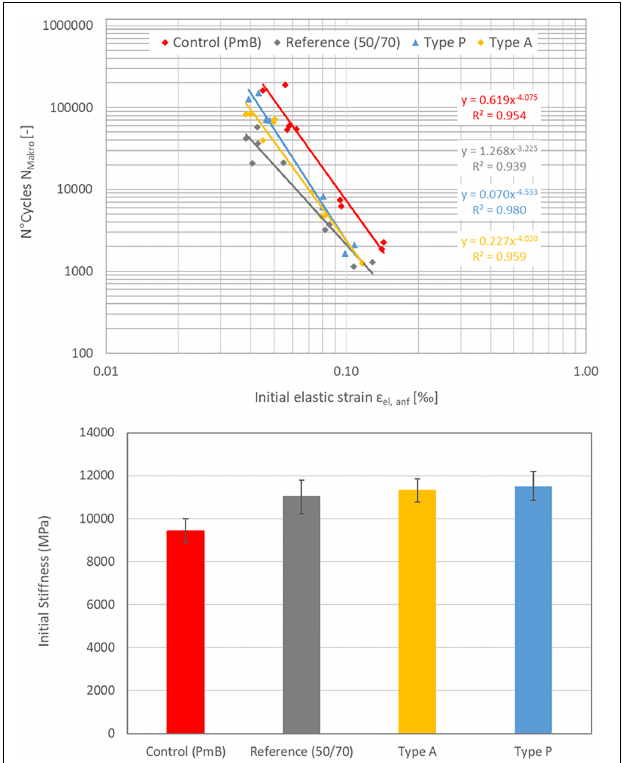
FIGURE 6 | Fatigue testing results for three different loading amplitudes at f = 10 Hz and at a test temperature of 20 ◦ C: loading cycles to fatigue failure Nmacro vs. initial strain level ε el (top) ; initial stiffness (bottom) .